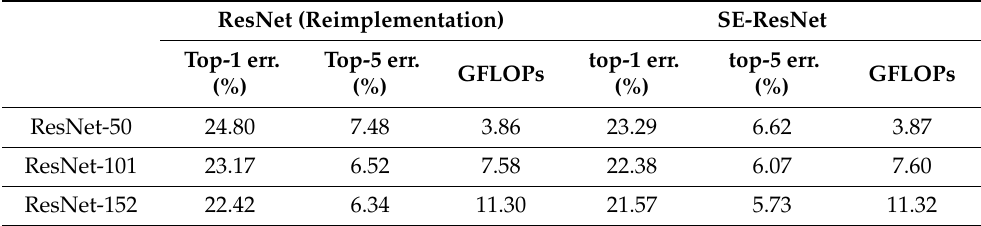
Table 2. Single-crop error rates (%) on the ImageNet validation set and complexity comparison of ResNets and SE-ResNets (source: [22]). GFLOPs refers to the amount of computation required for forwarding a single 224 × 224 pixel input